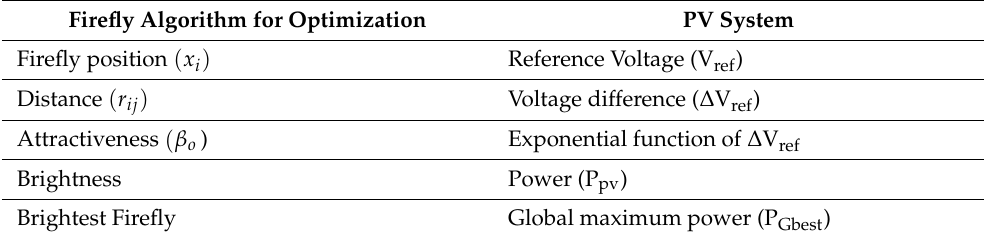
Figure 14. Flowchart of FA-MPPT Controller. Table 2 shows terminology of FA versus PV system as given below. Table 2. Terminology of FA vs PV